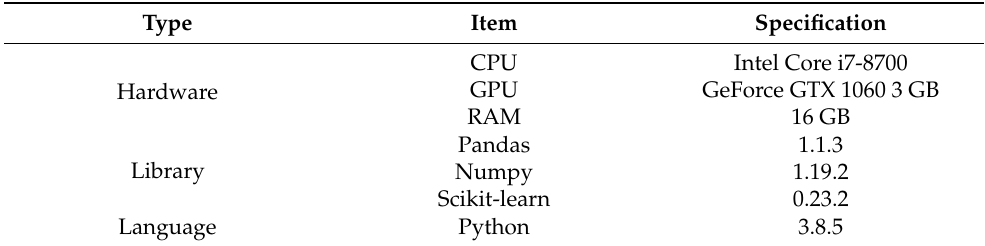
Table 1. H/W and library specification. Indicates hardware specifications and detailed Python library versions used in this study.